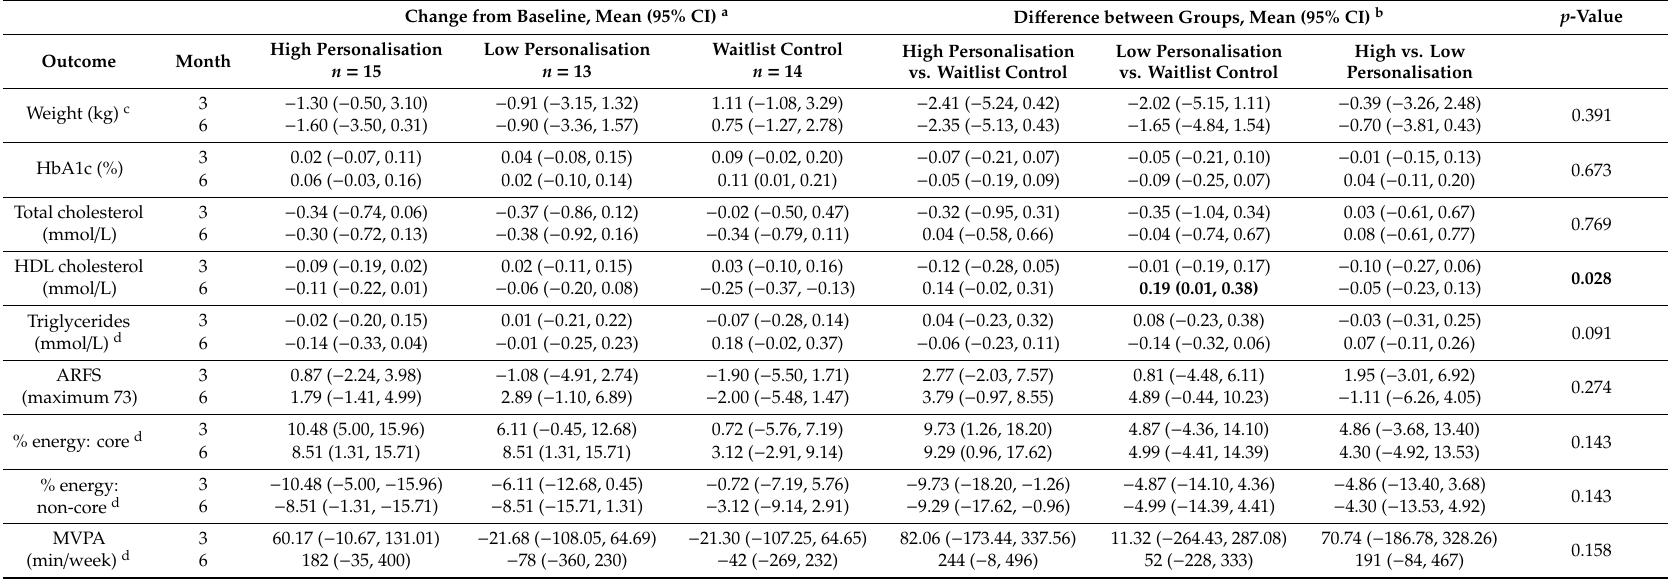
Table 2. Mean (95% CI) change in preliminary e ffi cacy outcomes within groups and between groups (intention-to-treat population) over time in a 6-month pilot randomised controlled trial for women with recent GDM who were at risk of developing T2DM. Change from Baseline, Mean (95% CI) a Di ff erence between Groups, Mean (95% CI) b p